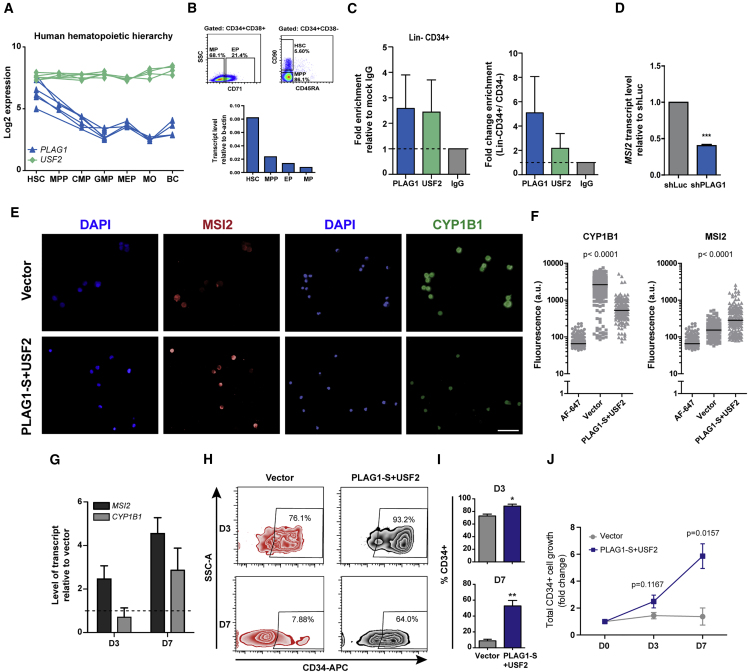
PLAG1-S and USF2 Co-regulate MSI2 Expression and Its Downstream Functions in Primitive Hematopoietic Cells(A) Expression profile of PLAG1 and USF2 in the human hematopoietic hierarchy. BC, band cell; CMP, common myeloid progenitor; GMP, granulocyte monocyte progenitor; MEP, megakaryocyte erythroid progenitor; MO, monocytes; MPP, multipotent progenitors.(B) Flow cytometry gating strategy to isolate erythroid progenitors (EP), myeloid progenitors (MP), MPP and HSCs from cord blood (top) and the q-RT-PCR validated expression of PLAG1-B within these populations (bottom, performed once from pooled CB samples).(C) ChIP-qPCR-defined fold enrichment of PLAG1 and USF2 at the MSI2 promoter in purified cord blood Lin-CD34+ (left) and fold change ChIP enrichment in Lin-CD34+ compared with Lin-CD34- (right) (n = 3 experiments).(D) qPCR determination of MSI2 transcript levels following PLAG1 knockdown in Lin-CD34+ cells (n = 3 experiments).(E) Representative immunofluorescence images of MSI2 and CYP1B1 proteins in Lin-CD34+ CB cells expressing control vector or co-overexpressing PLAG1-S and USF2 and cultured for 7 days. Scale bar, 25 μm.(F) Quantification of MSI2 and CYP1B1 expression on a per cell basis. Each point in the graph represents an individual stained cell and the solid line denotes the mean fluorescence intensity of each dataset. Cells stained with Alexa Fluor 647 (AF-647) conjugated secondary antibody alone were considered as background fluorescence controls (>100 cells analyzed per condition for each experiment, plots summarize n = 3 experiments).(G) Fold change in the transcript level of MSI2 and CYP1B1 upon co-expression of PLAG1-S and USF2 at day 3 (D3) and day 7 (D7) of in vitro culture relative to vector control.(H) Representative flow cytometry plots showing the frequency of CD34+ cells at the D3 and D7 in vitro culture points with the co-overexpression of PLAG1-S and USF2.(I) Quantification of CD34+ cell frequency (n = 3 experiments).(J) Fold change in total CD34+ cells over the 7-day culture period.Data are presented as means ± SEM. ∗p < 0.05, ∗∗p < 0.01, ∗∗∗p < 0.001. See also Table S3.